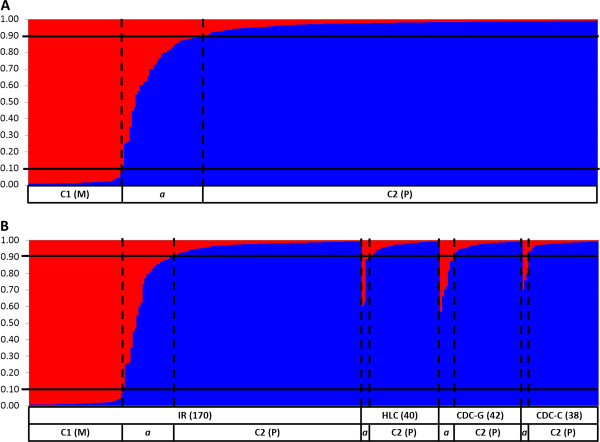
Bayesian cluster analysis of Cx. pipiens s.s. mosquitoes conducted by STRUCTURE in Comporta (2010). A: Individuals sorted by their ancestral probability; B: Individuals sorted by collection method and ancestral probability; IR: indoor resting inside shelters; CDC-G: CDC light traps in ground level; CDC-C: CDC light traps in canopy of trees; HLC: human landing catches; a: admixed individuals (0.1 < Tq < 0.9). Columns correspond to the multilocus genotype of each individual, partitioned in different colours representing the probability of ancestry (qi) to each cluster (Red: molestus; Blue: pipiens). Individuals were ordered according to their geographic information. Lines indicate the qi threshold used to determine admixed individuals (see Methods).